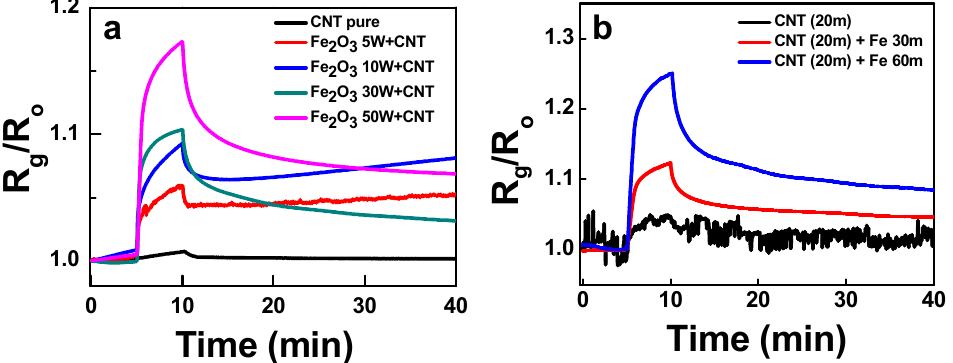
Figure 6. The response to 500 ppm NH 3 of the Fe 2 O 3 :SWCNT composite structures ( a ) fabricated by the arc-discharge method with varying number of iron wires inserted to the graphite rod from five to 50 wires, and ( b ) fabricated by sputter deposition of Fe for 30 and 60 min on the SWCNT mat structures.